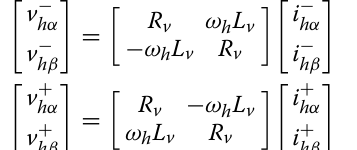
Fig. 5 Frequency characteristics of T 11 (s) /G 11 (s) and T 11q (s) /G 11q